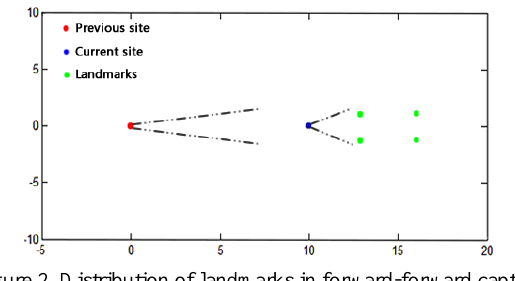
Figure 2. Distribution of landmarks in forward-forward capture configuration